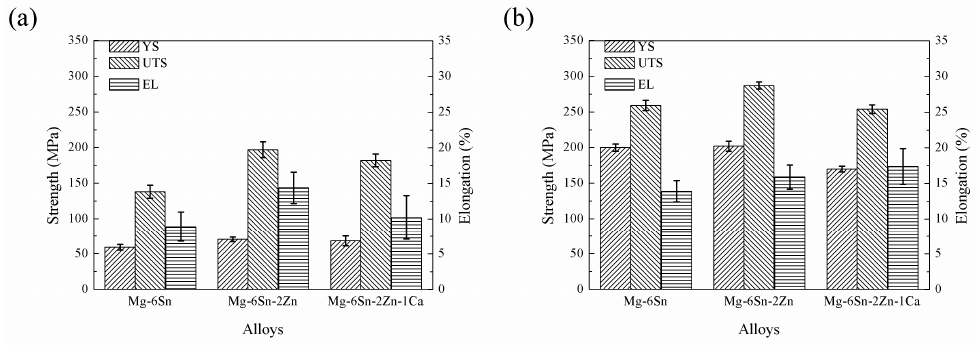
Figure 10. Strength and elongation at room temperature of as-cast and as-extruded Mg-Sn alloys: ( a ) as-cast and ( b ) as-extruded.